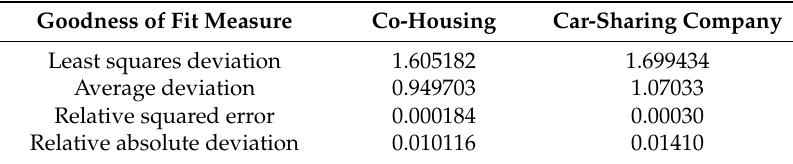
Table 3. Goodness of fit for linear estimation.